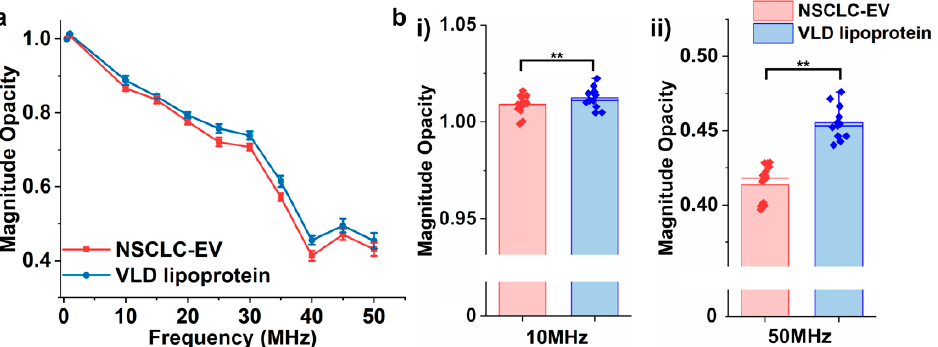
Figure 6. ( a ) Magnitude opacity spectrum of EVs derived from A549 non-small cell lung cancer (NSCLC) cell line and very low-density (VLD) lipoprotein. ( b ) Bar plots of magnitude opacity comparison of NSCLC and VLD lipoproteins at 10 MHz and 50 MHz. (** P < 0.05, n = 12).